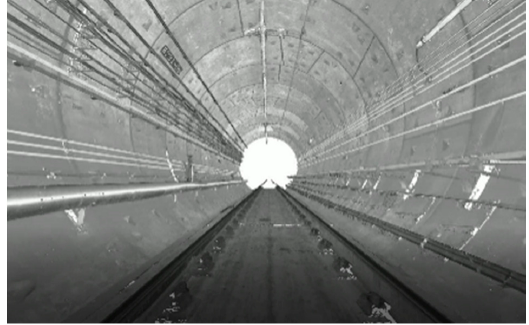
Figure 7. Roaming video screenshot.